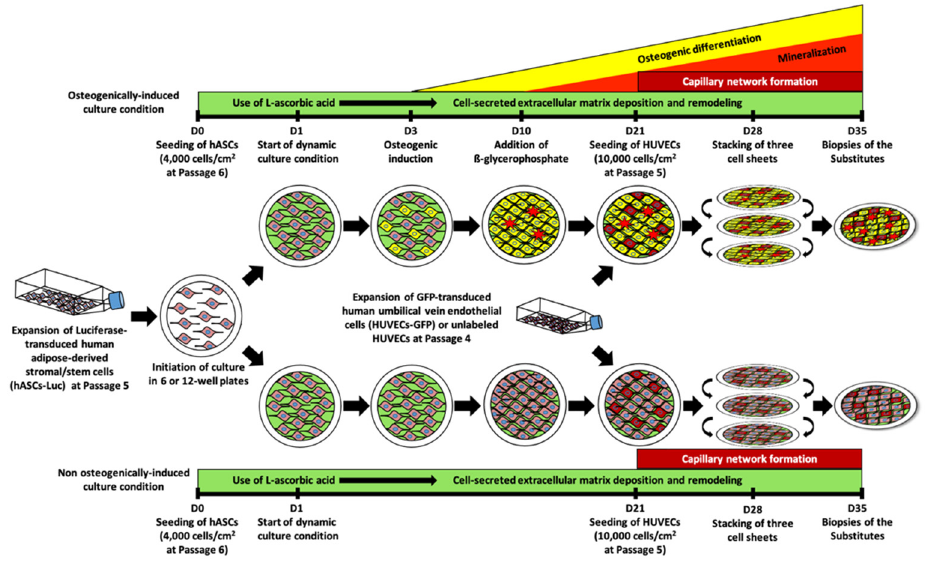
Figure 1. Schematic of the self-assembly approach of tissue engineering applied to the production of cell-derived prevascularized bone-like substitutes. Banked human adipose-derived stromal/stem cells (hASCs) were expanded at Passage 5 for a week. Subsequently, cell-secreted extracellular matrix deposition (green rectangles) was initiated by seeding hASCs at Passage 6 in 6- or 12-well plates at day 0 (D0), which were exposed to L-ascorbic acid stimulation until the day of the biopsies (D35). A dynamic wave-like movement was started one day after seeding the expanded hASCs (D1) and continued until the end of the culture period (D35) to favor cell sheet formation. However, to allow cell adhesion, the dynamic culture was stopped for 24 h, following endothelial cell seeding (D21). Osteogenic induction (yellow triangle) was started at day 3 (D3) to achieve osteoblastic differentiation and mineralization (red triangle). Expanded endothelial cells (HUVECs) were seeded (Passages 4 to 5) on top of the cell sheets at day 21 (D21) and spontaneously formed capillary networks (red rectangles) within one week. Finally, three prevascularized cell sheets containing capillary networks were stacked together at day 28 (D28) and cultured for an additional week to create a prevascularized bone-like tissue. Using the same process of self-assembly, prevascularized and non-prevascularized stromal tissues were produced from hASCs in the absence of osteogenic stimulation and served as controls.